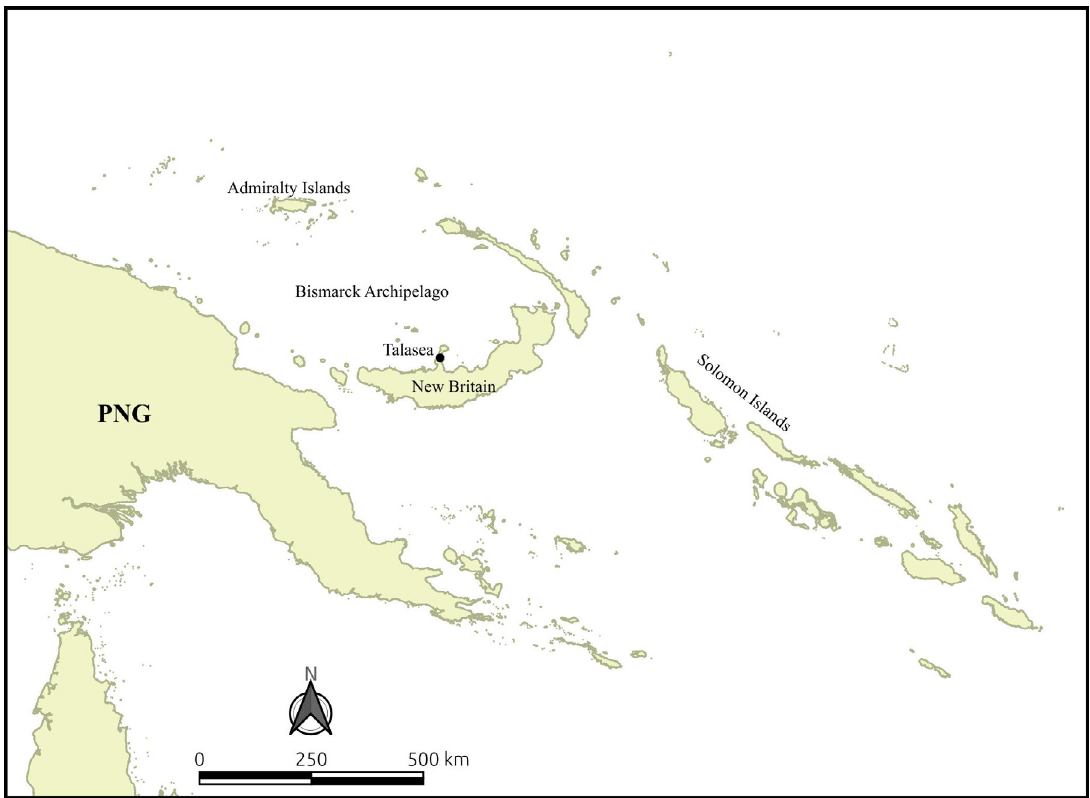
Figure 3. Map of the Bismarck Archipelago showing the geological sources from Talasea, New Britain and Admiralty